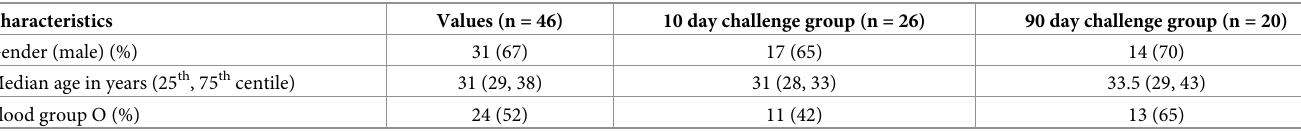
Table 1. Characteristics of study participants.